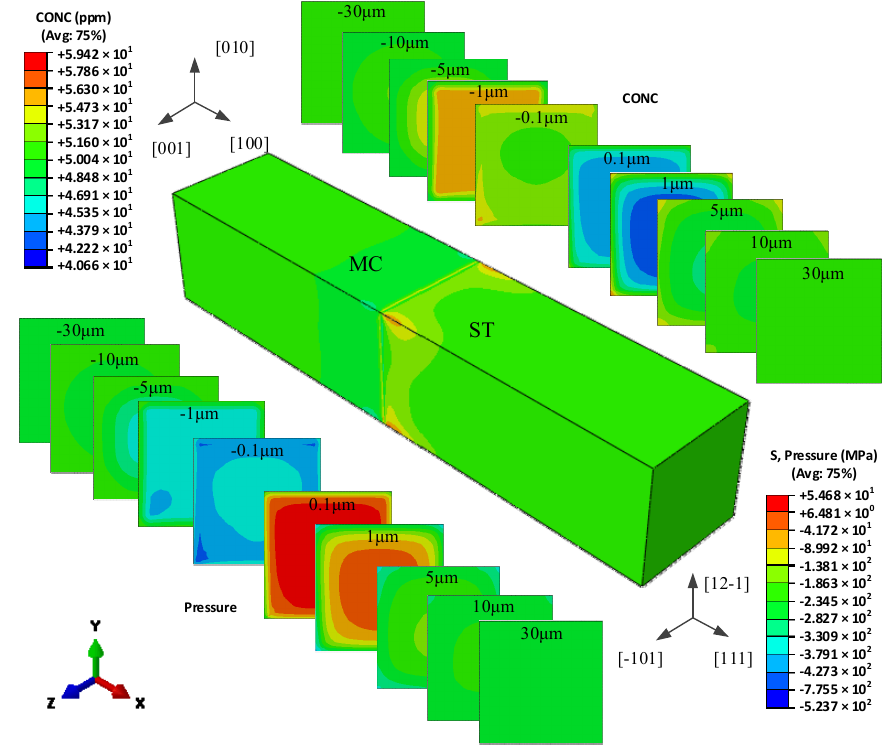
Figure 8. The hydrogen concentration distribution in model II bicrystal.